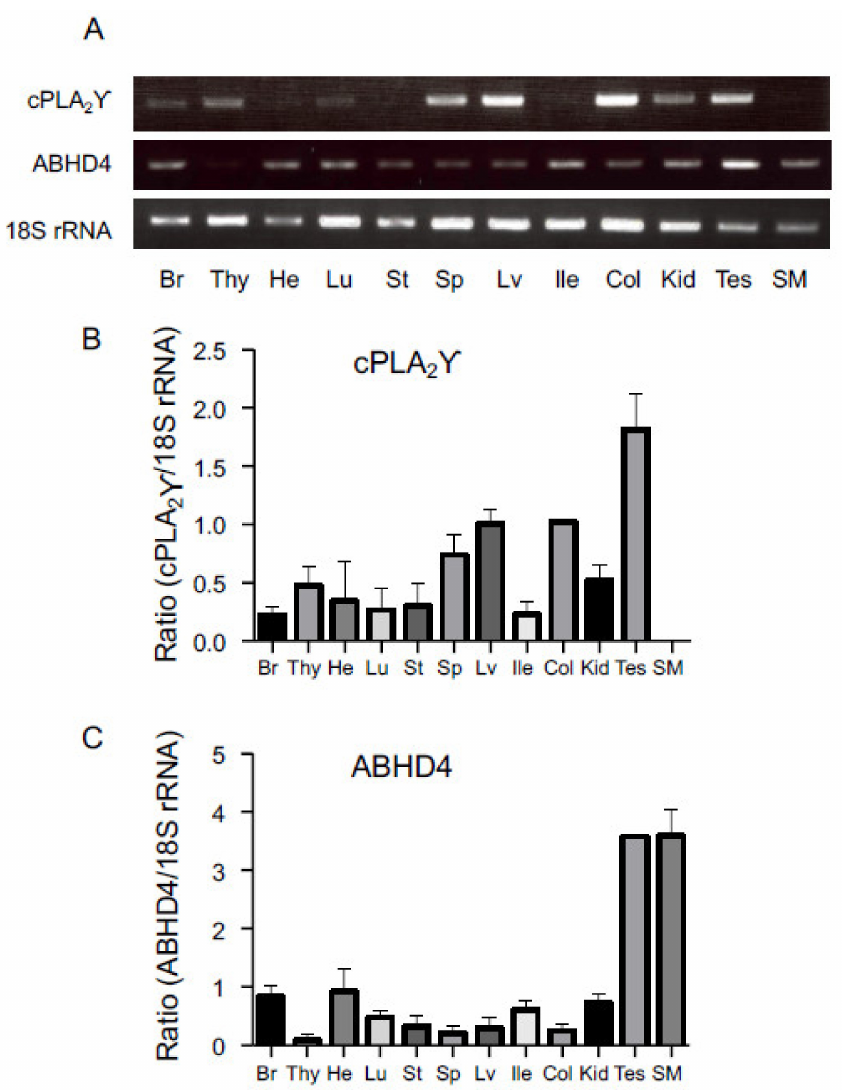
Figure 7. Tissue distribution of cPLA 2 γ and ABHD4 in mice. mRNAs from the indicated mouse tissues were analyzed by reverse transcription-PCR using primers specific for cPLA 2 γ , ABHD4, and 18S rRNA (a control) ( A ). The semi-quantitative results are also shown (mean values ± S.D., n = 3) ( B , C ). Br: brain; Thy: thymus; He: heart; Lu: lung; St: stomach; Sp: spleen; Lv: liver; Ile: ileum; Col: colon; Kid: kidney; Tes: testis; SM: skeletal